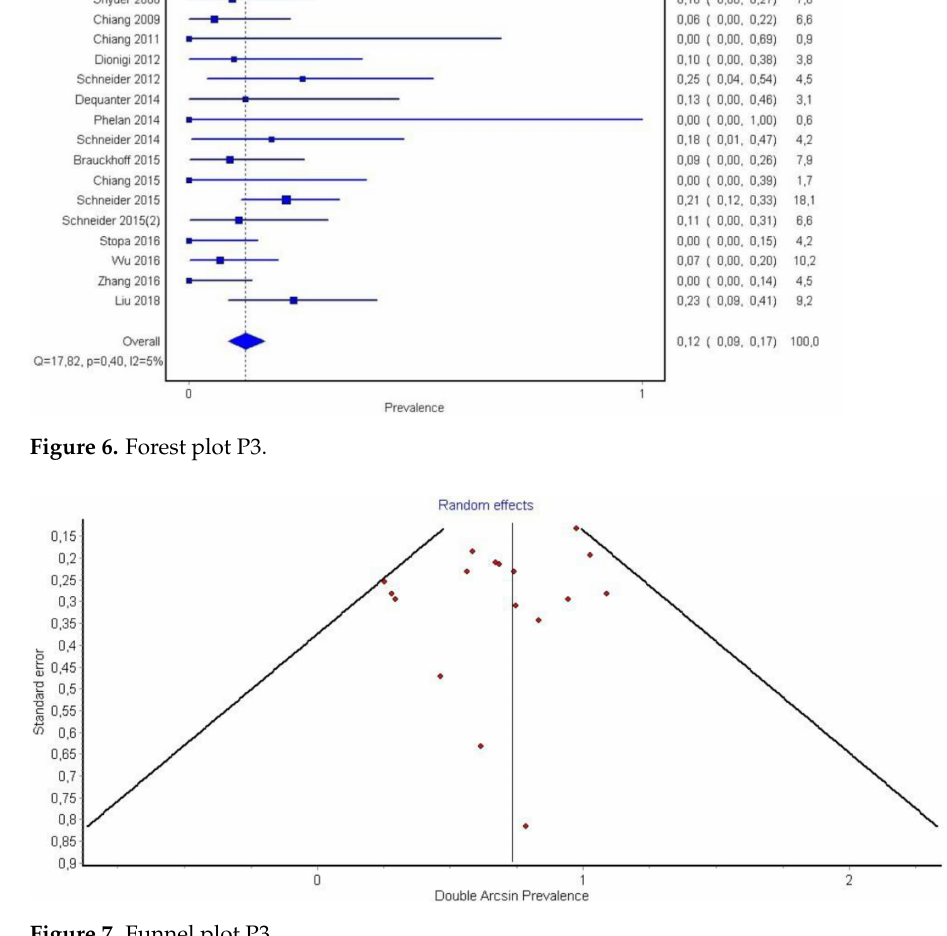
Figure 7. Funnel plot